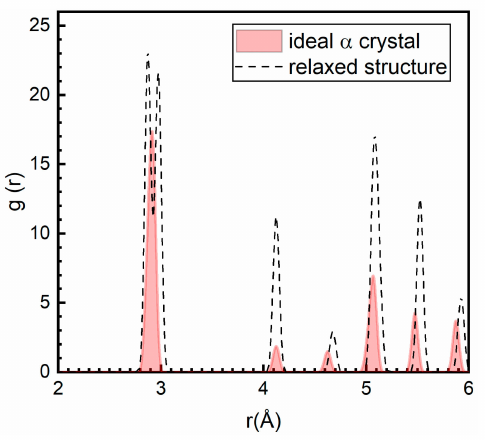
Figure 3. The radial distribution functions of ideal α crystal and the final relaxed